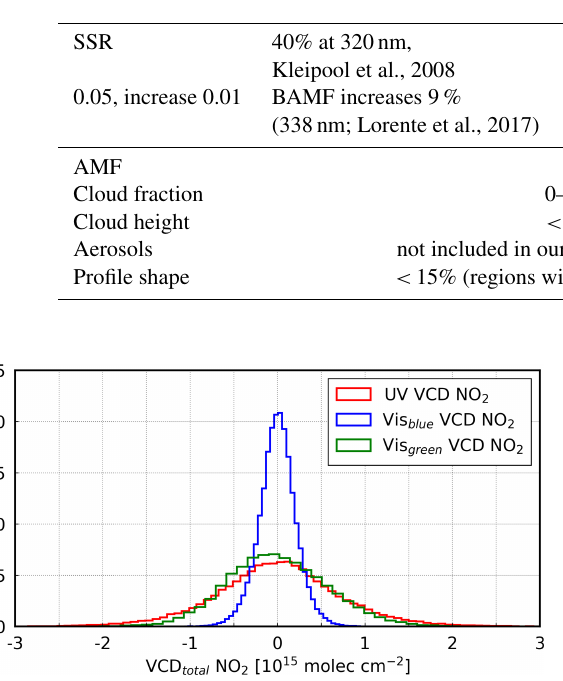
Figure 4. Distribution of total NO 2 VCDs over a clean region (equatorial Pacific: 5 ◦ S–5 ◦ N, 150–210 ◦ E) for three fitting win- dows in the UV, green, and blue spectral range for January 2008. Curves are normalized to unit area and centred on